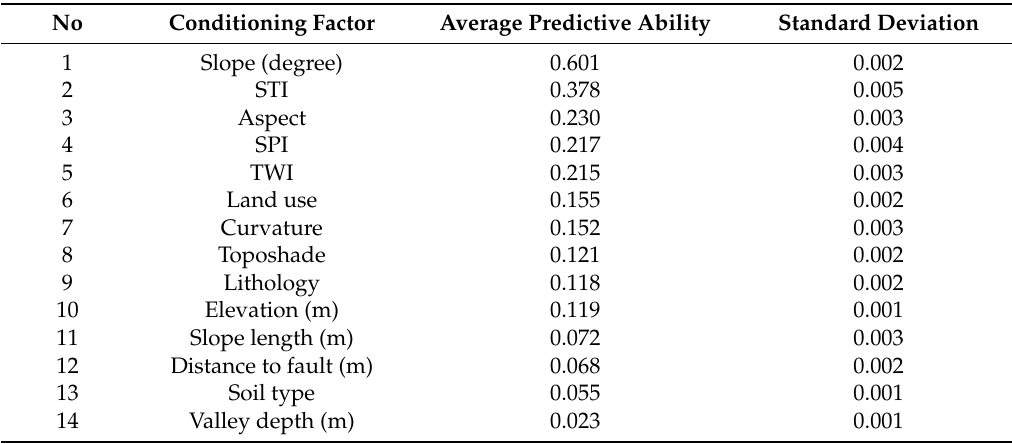
Predictive ability of the fourteen influencing factors using the Information Gain Ratio